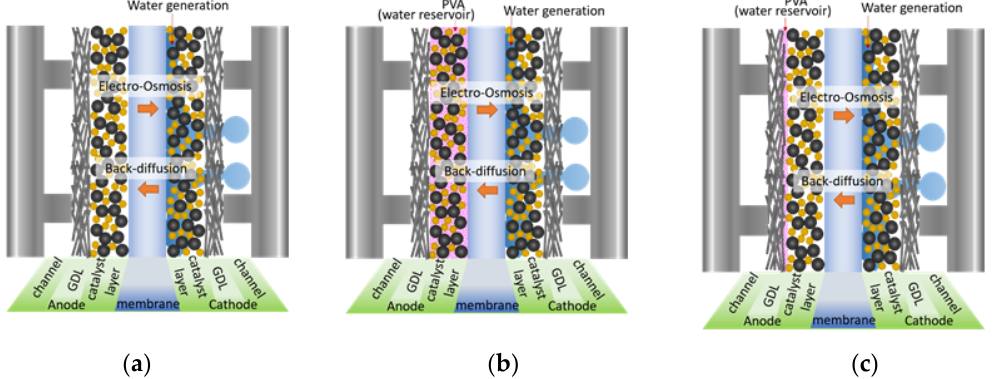
Figure 1. Schematic of a single cell with different electrode configurations: ( a ) no polyvinyl alcohol (PVA) case, ( b ) PVA in the anode catalyst layer (CL), and ( c ) PVA on the gas diffusion layers (GDLs).